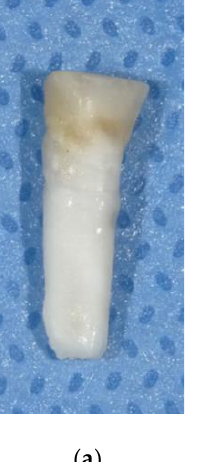
Figure 2. ( a ) Mandibular right central primary incisor, exfoliated at the age of 4 years and 1 month. ( b ) micro-CT analysis of the exfoliated tooth.